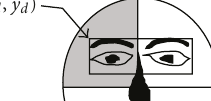
Figure 9: Average face template.